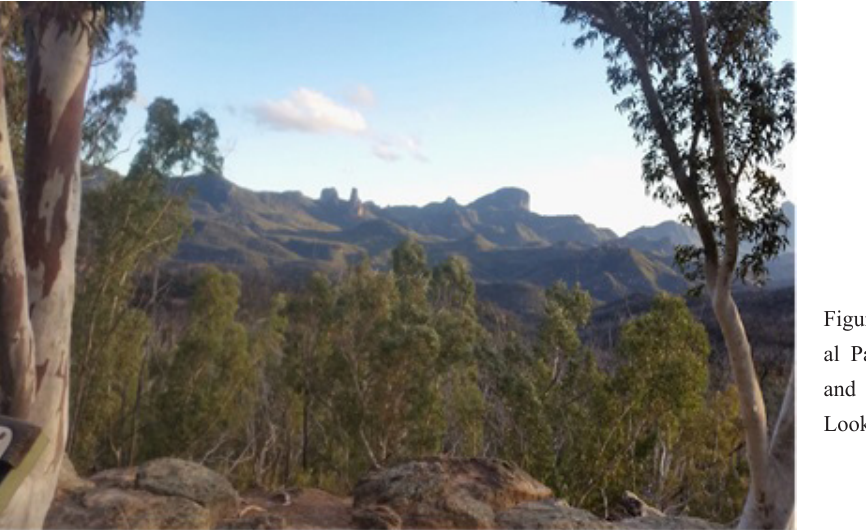
Figure 10. Warrumbungle